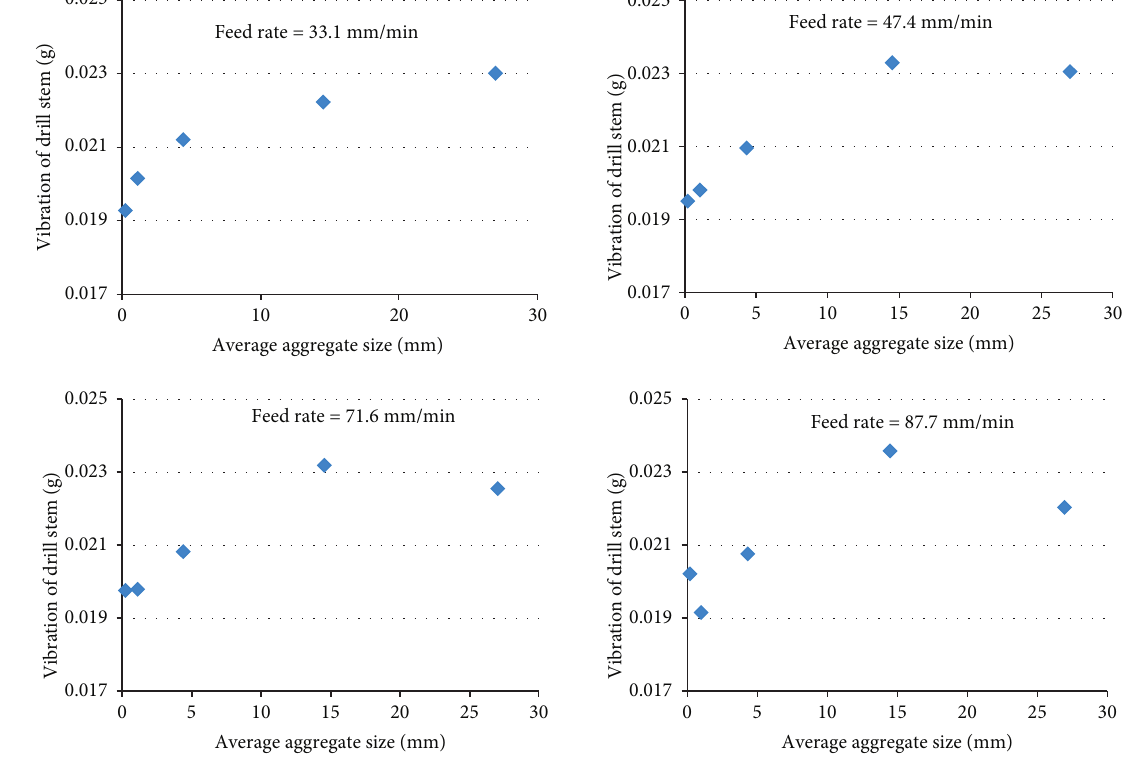
Figure 6: Drill stem vibration vs. average aggregate